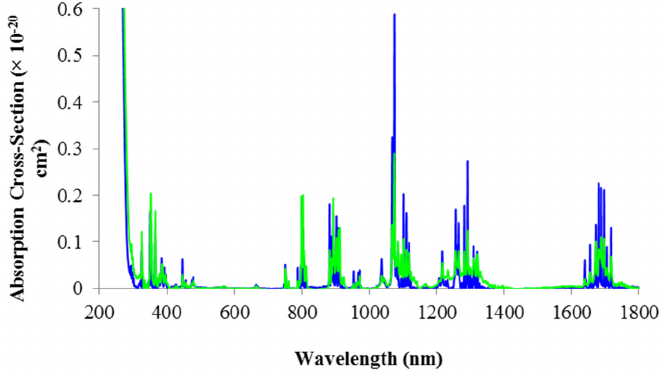
Figure 42. Absorption cross-section as a function of wavelength for a hydrothermally-grown Dy 3+ :YAG crystal at 80 K (blue) and 298 K (green).